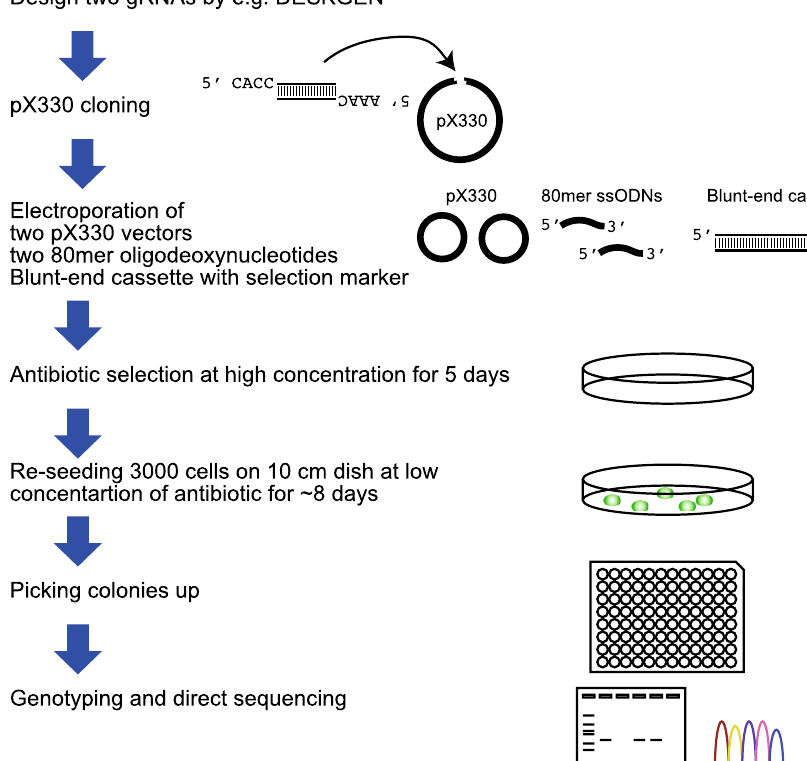
Figure 1. The schema of SUCCESS. SUCCESS requires the construction of only 2 pX330 plasmids and 2 single-strand oligodeoxynucleotides (ssODNs) to delete the full length of the target gene from the genome. The blunt-end cassette with selection marker can be used for any gene